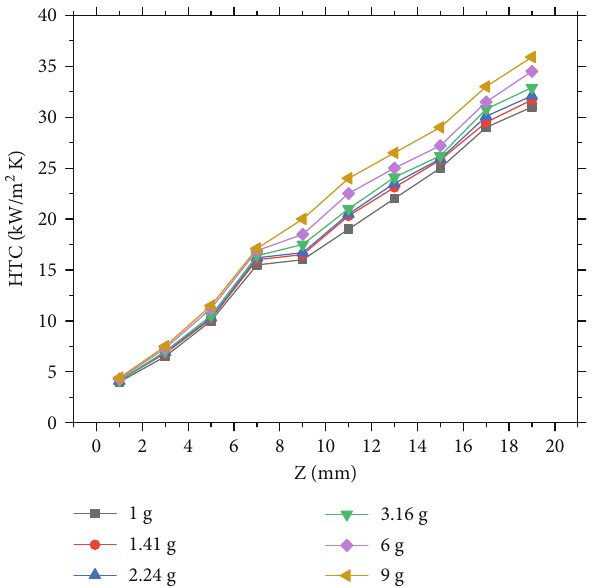
Figure 11: Heat transfer coe ffi cient of 0.1% nano fl uid under hypergravity.